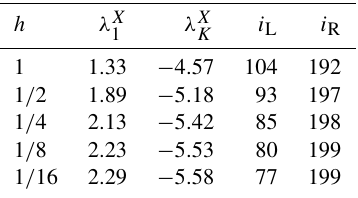
) and smallest ( λ X ) LE with the K 1